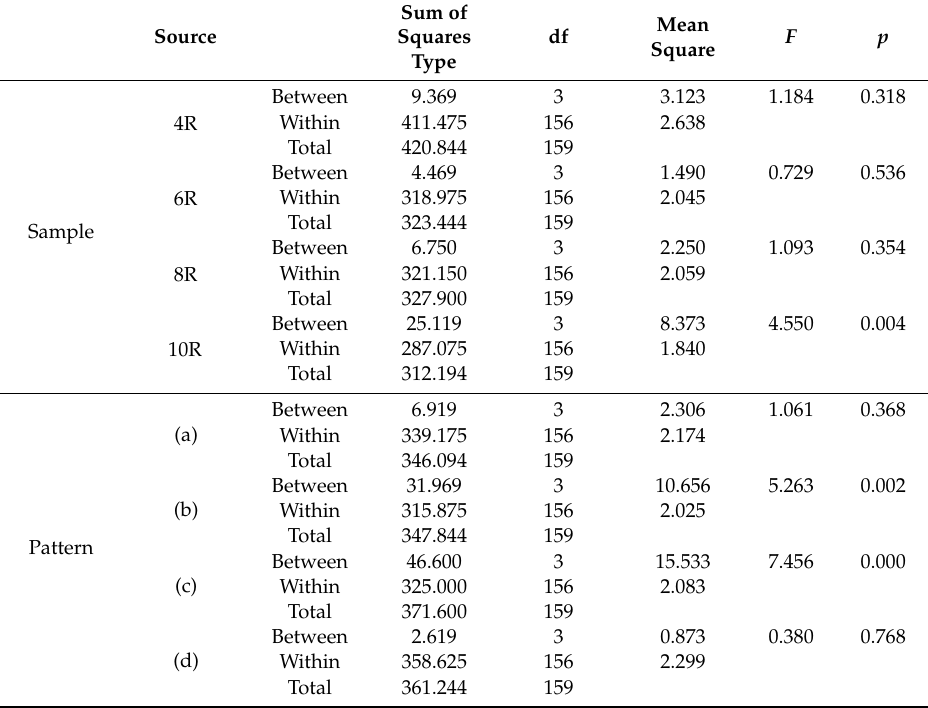
Table 8. Results of one-way ANOVA for control comfort by each sample and usage pattern.